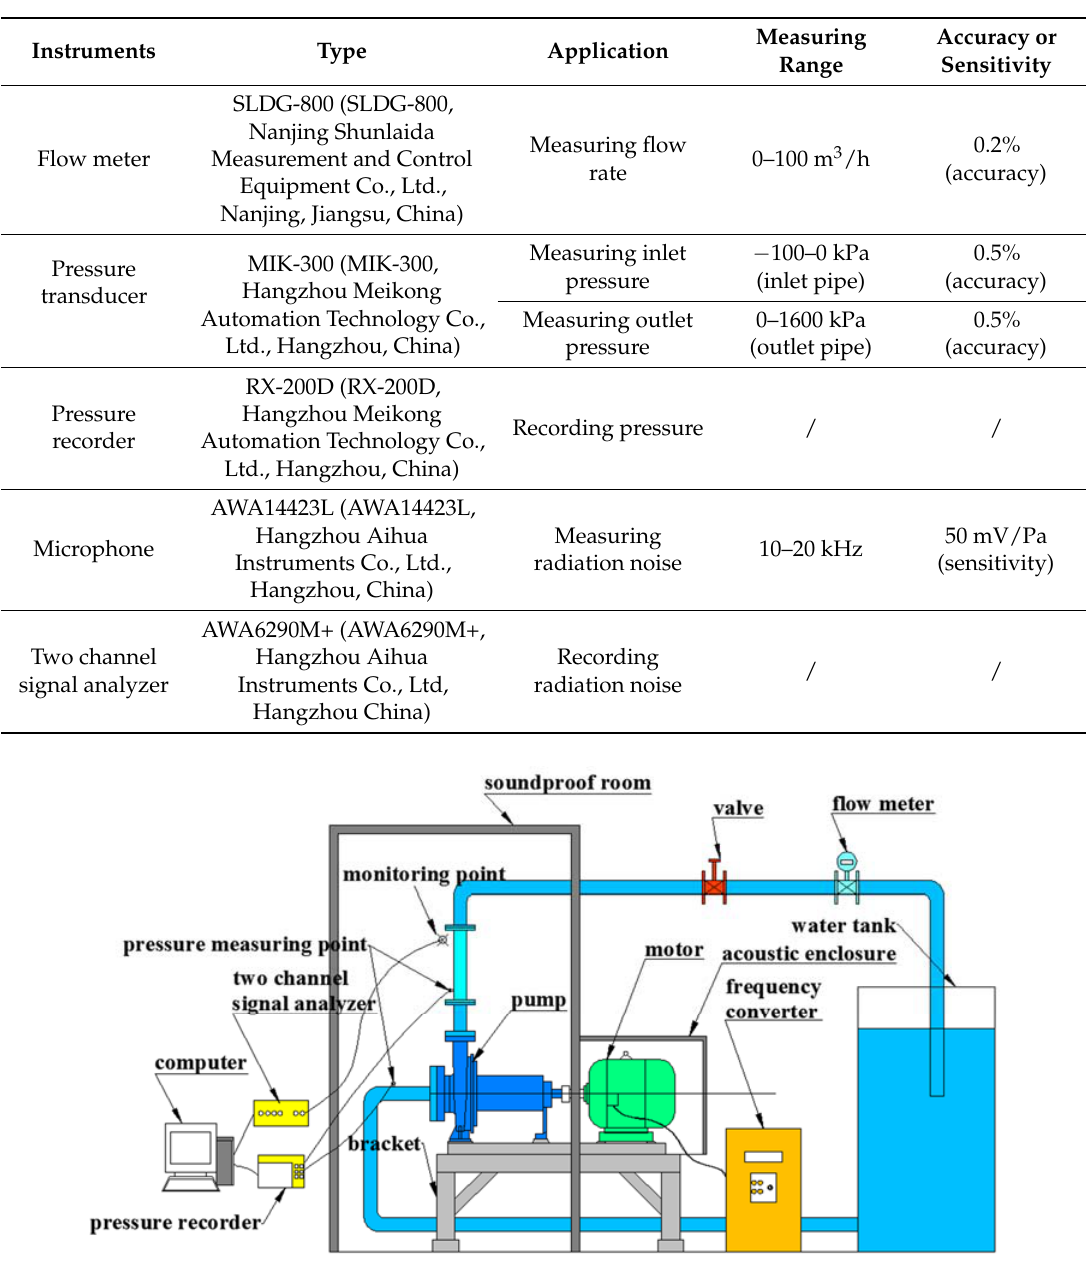
Table 2. Measurement characteristic of instruments.